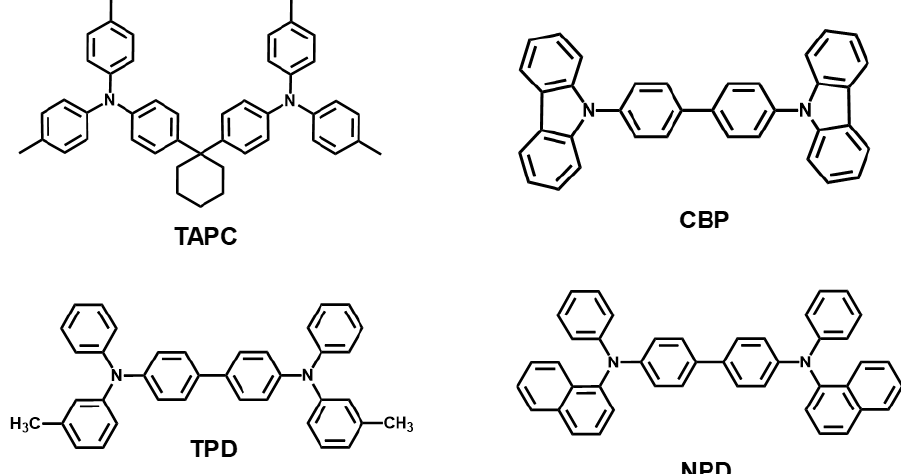
Figure 1. Chemical structures of materials used in phosphorescent emission layer; FIrpic blue triplet emitter, PVK host, and OXD-7.